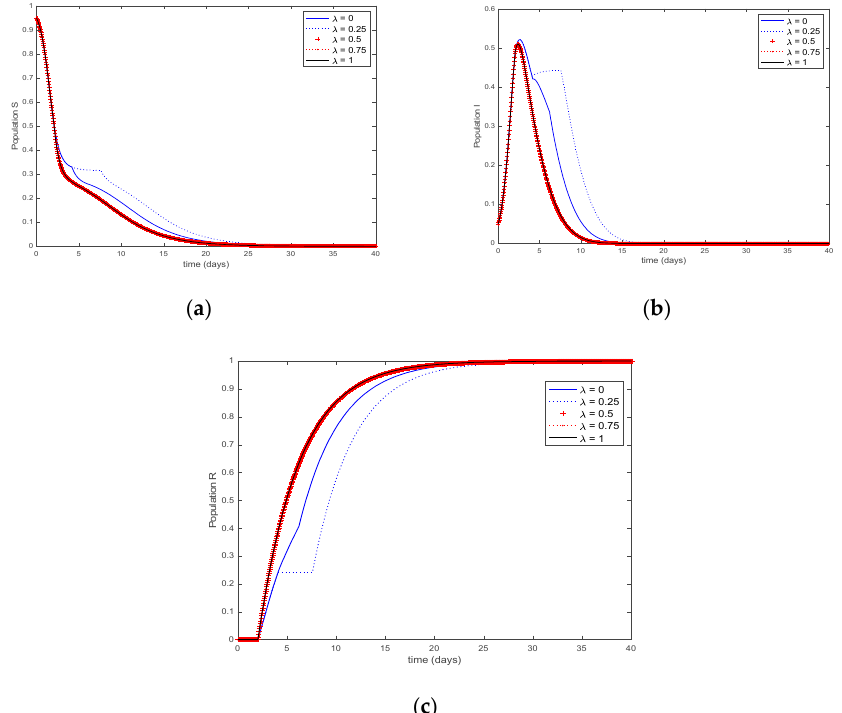
Figure 3. Evolution of the model’s populations for different values of λ and Algorithm 1. The model’s parameters are β = 2.5 and γ = 0.79 days − 1 while T min = 2 days and S KV = S KT = { 0 0.001 0.0035 0.0075 0.01}. ( a ) Susceptible. ( b ) Infectious. ( c ) Immune. It is interesting to notice that the